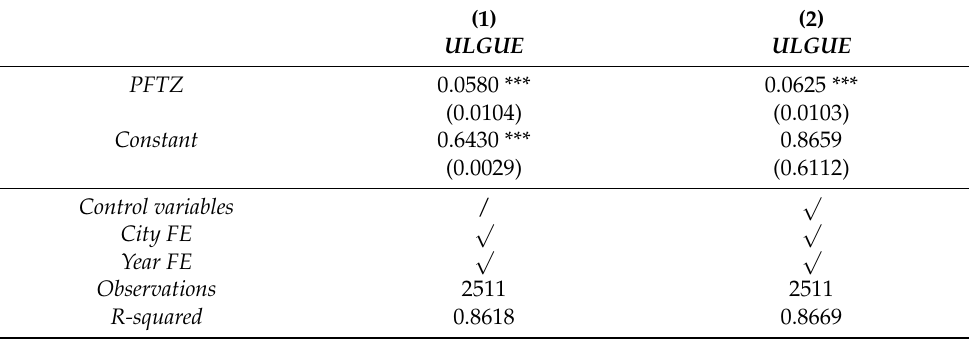
Table 5. Entropy-balancing